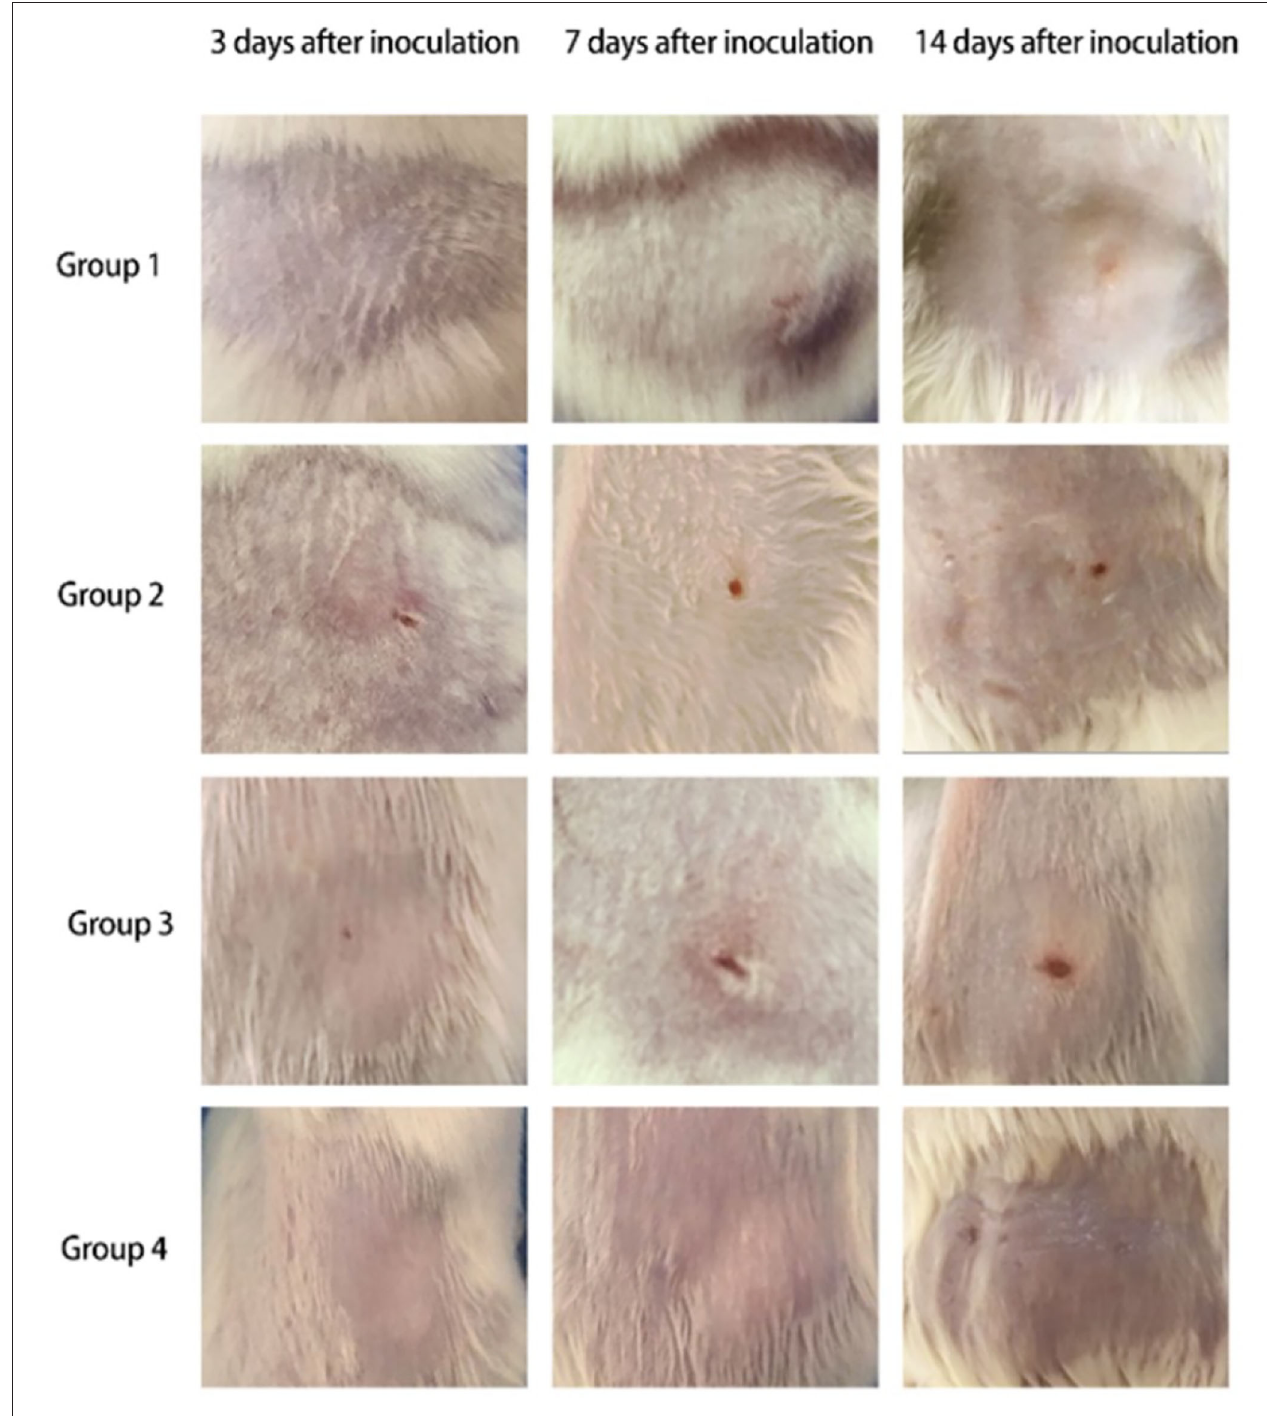
FIGURE 1 | Skin changes of mice in each group (Group 1: CTX 80 mg/kg · d, Group 2: CTX 90 mg/kg · d, Group 3: CTX 100 mg/kg · d, Group 4: CTX 100 mg/kg · d as the control group).